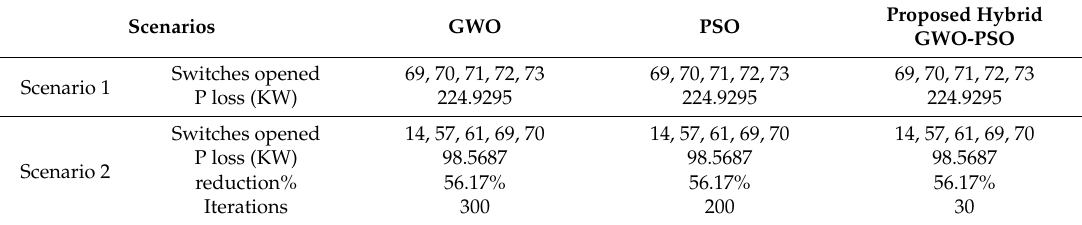
Table 5. Comparison of simulation results for P-type DG units of the 69-bus